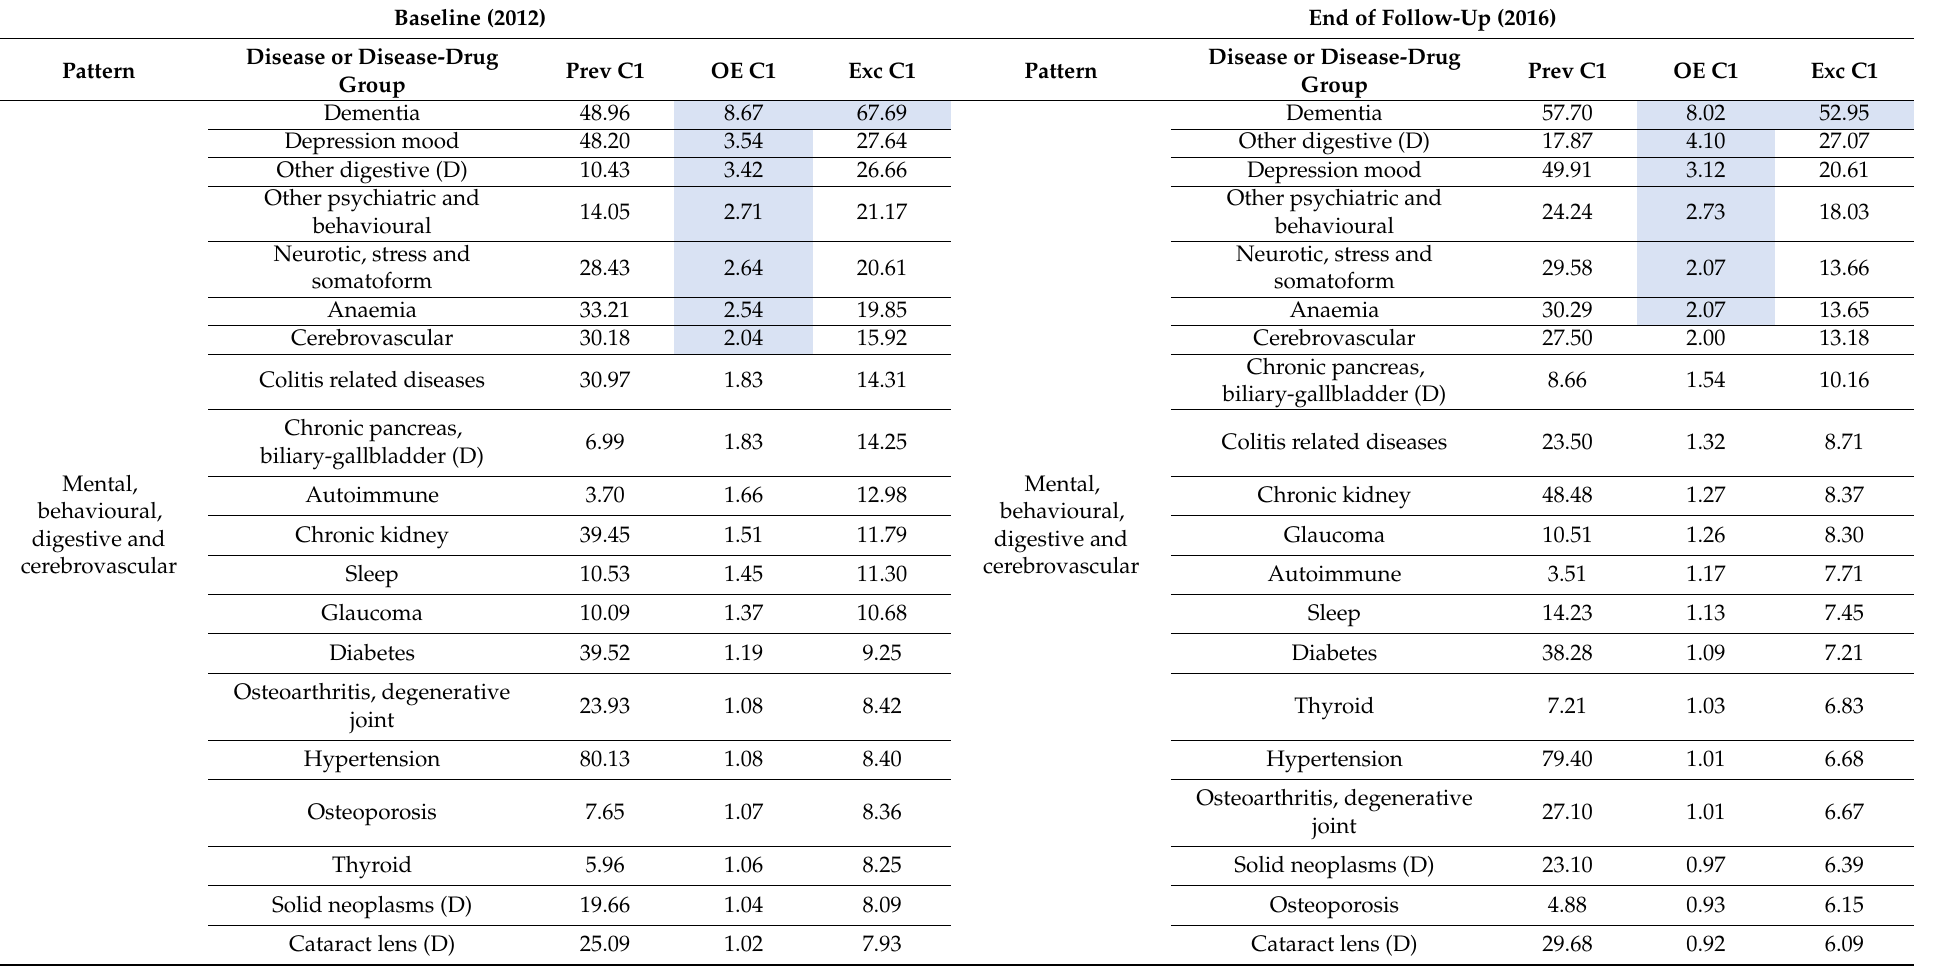
Table 3. Evolution of combined multimorbidity and polypharmacy patterns associated with more